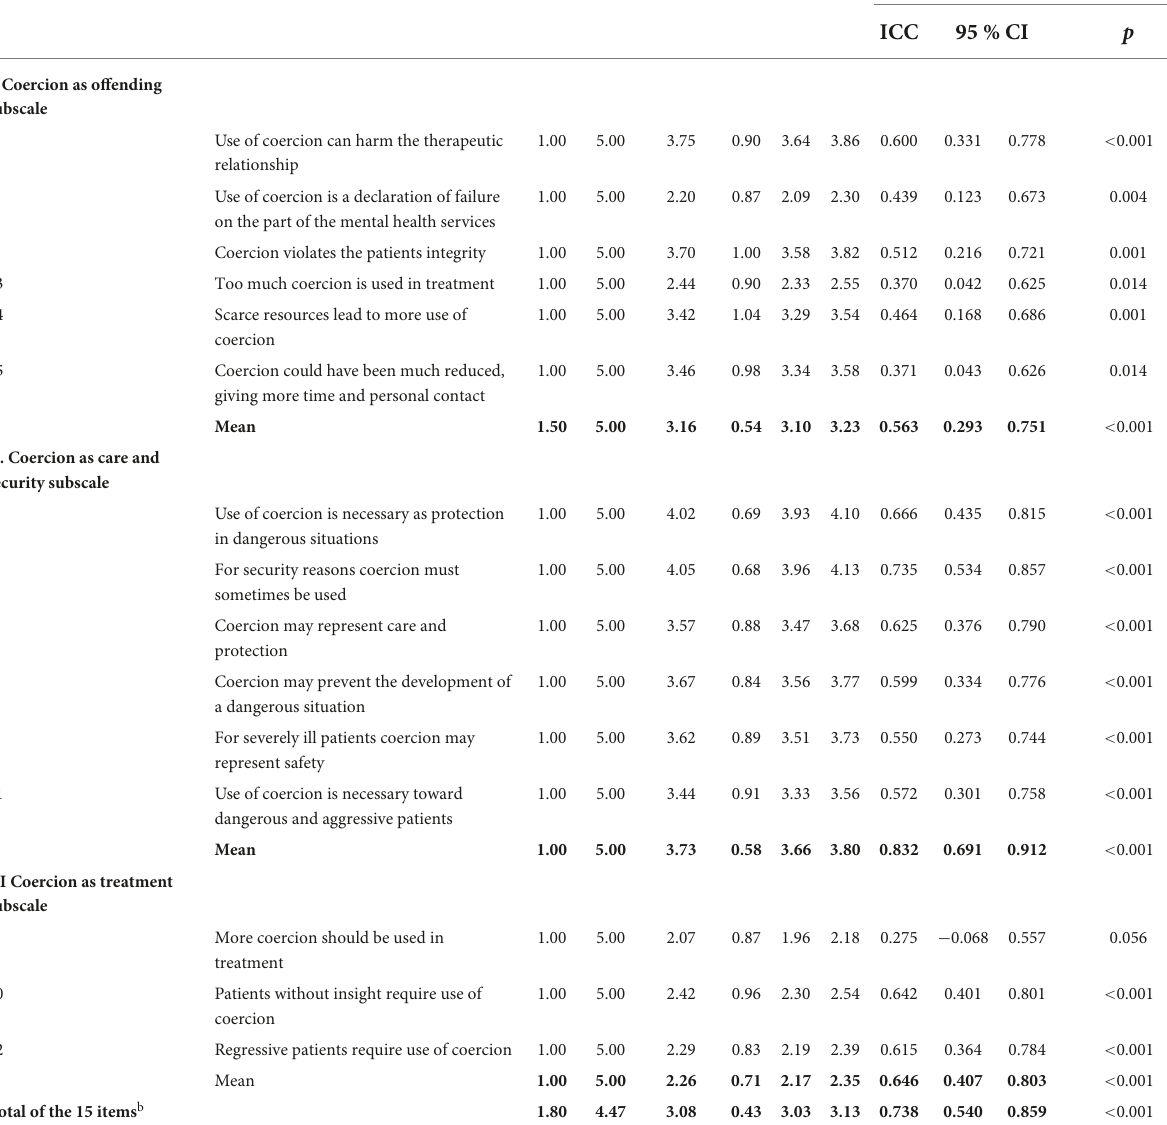
TABLE 2 Minimum, maximum, mean, standard deviation, and 95% confidence interval of the items of SACS calculated in the responses of the initial survey, and their intraclass correlation coefficient calculated among those who participated both in the initial and the second survey ( N =